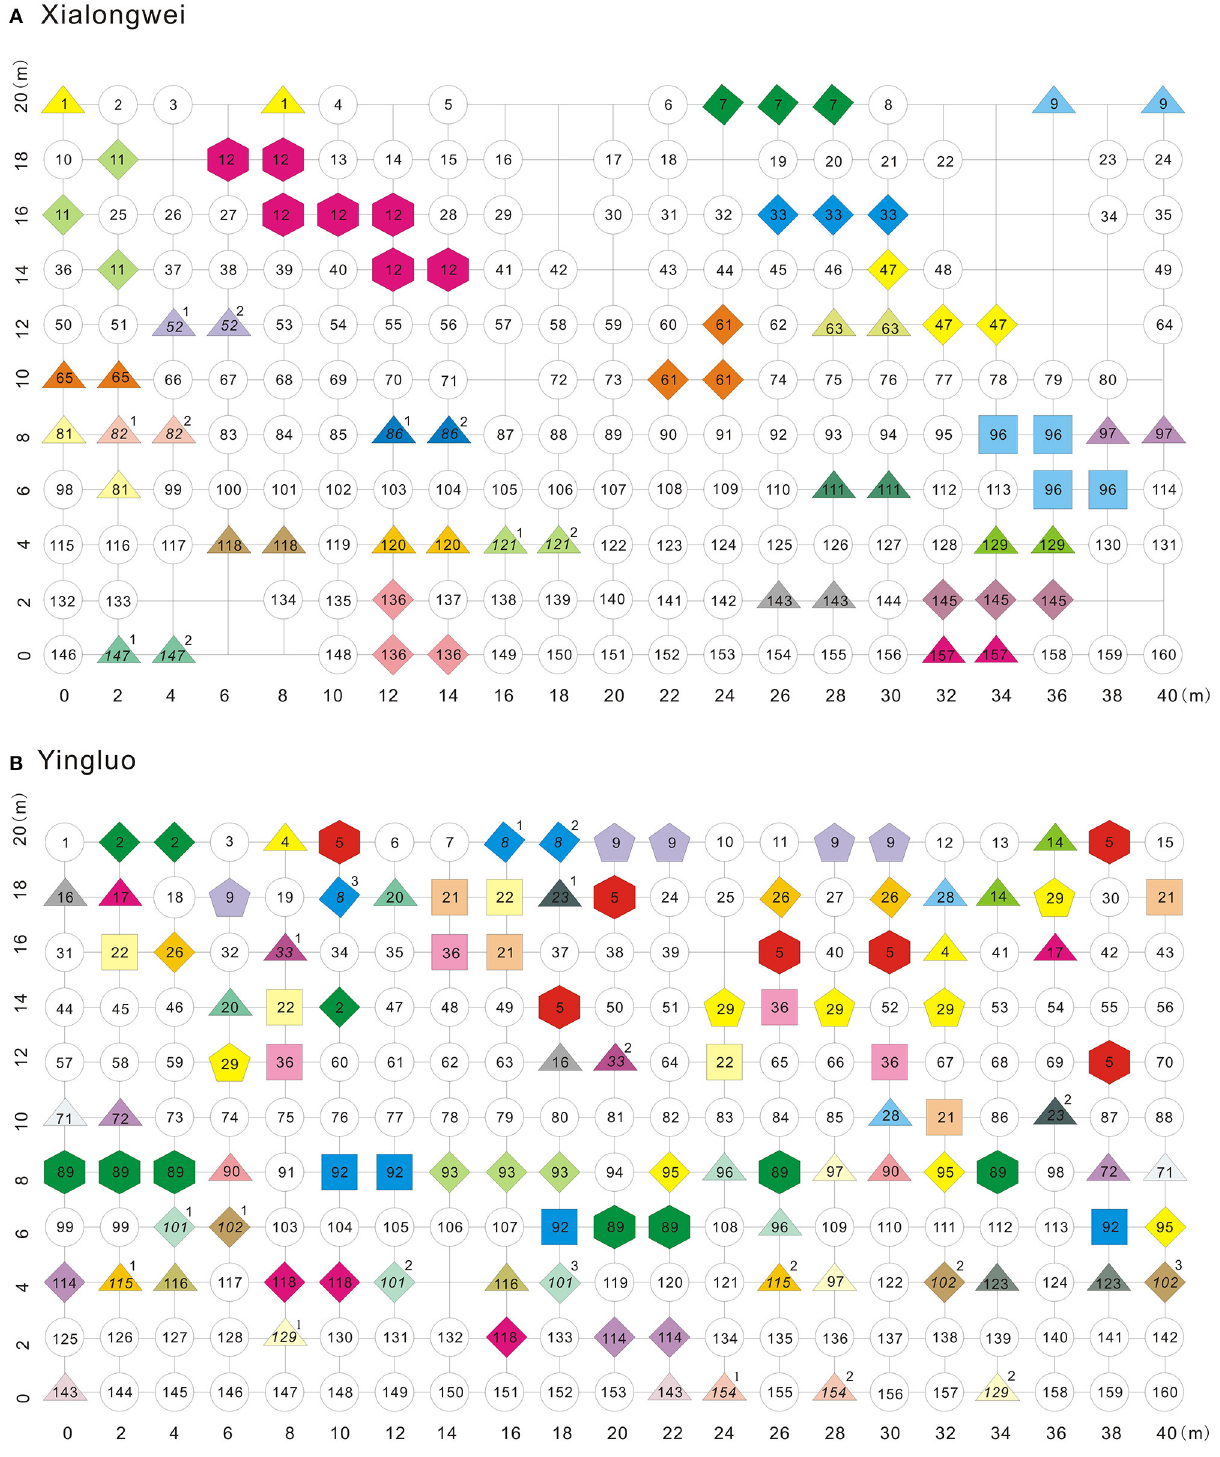
Frontiers in Ecology and Evolution |